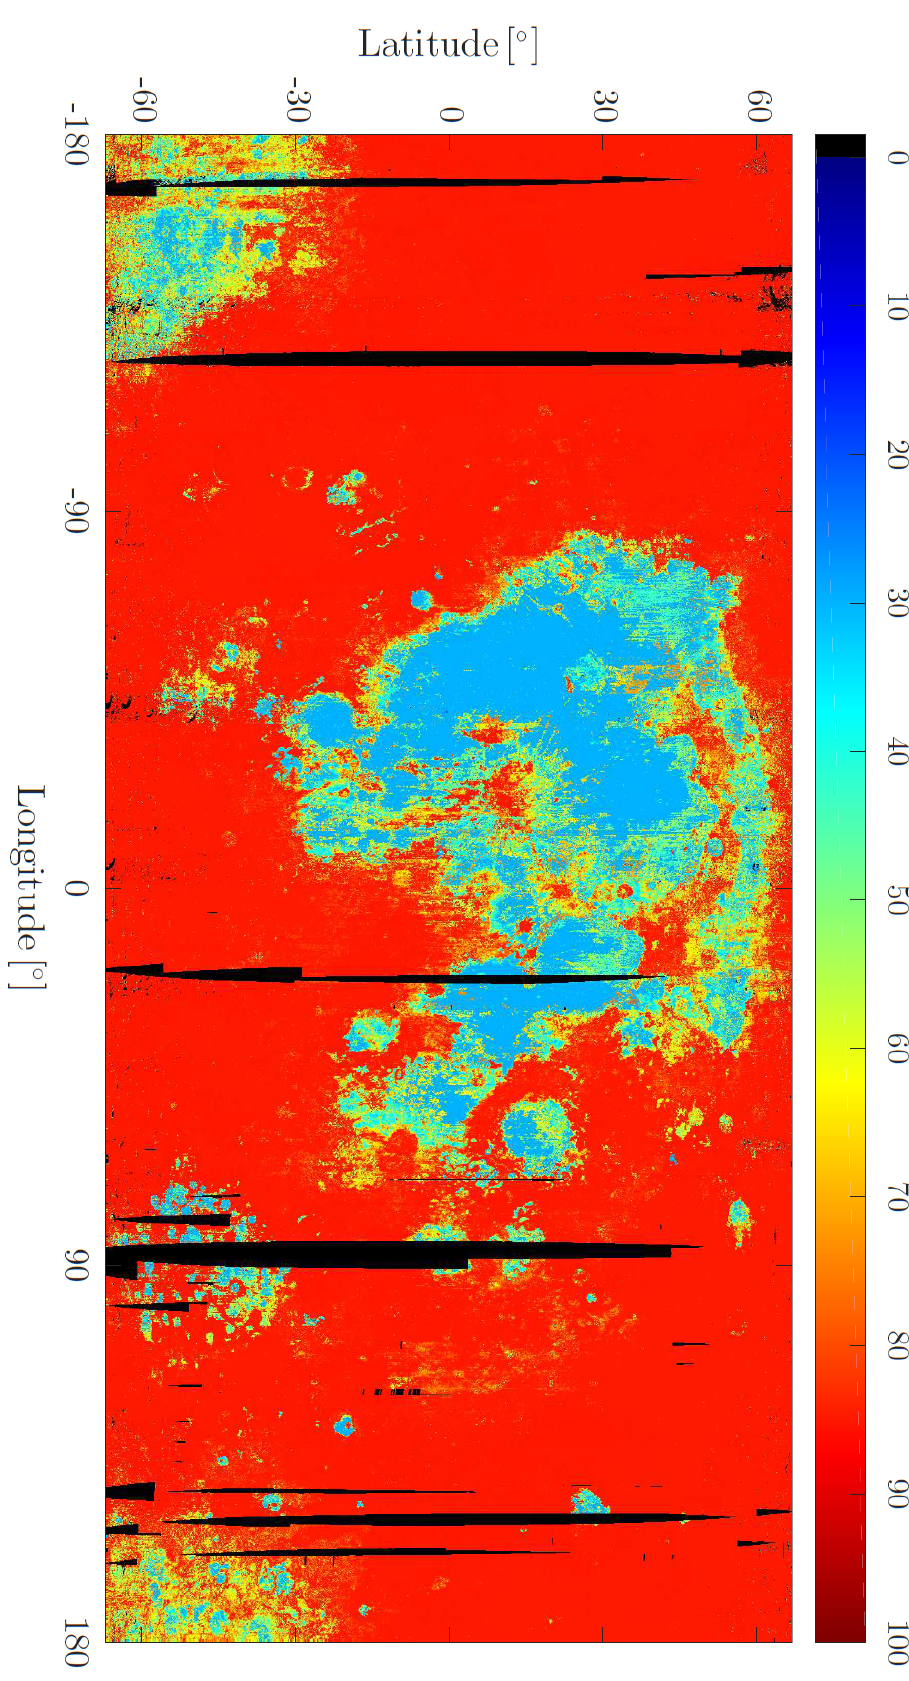
Figure 1. Map of the fractional abundance of plagioclase (in percent). Black pixels denote missing